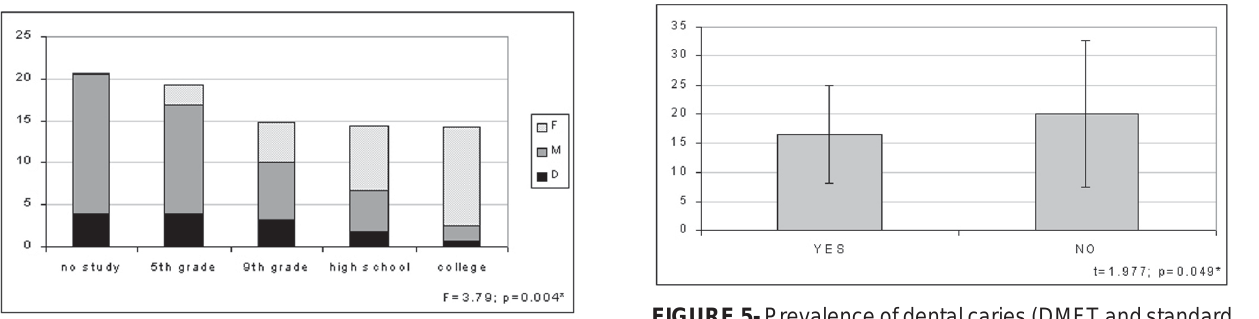
FIGURE 3- Prevalence of dental caries (DMFT) according to educational level. Bauru, Brazil, 2001